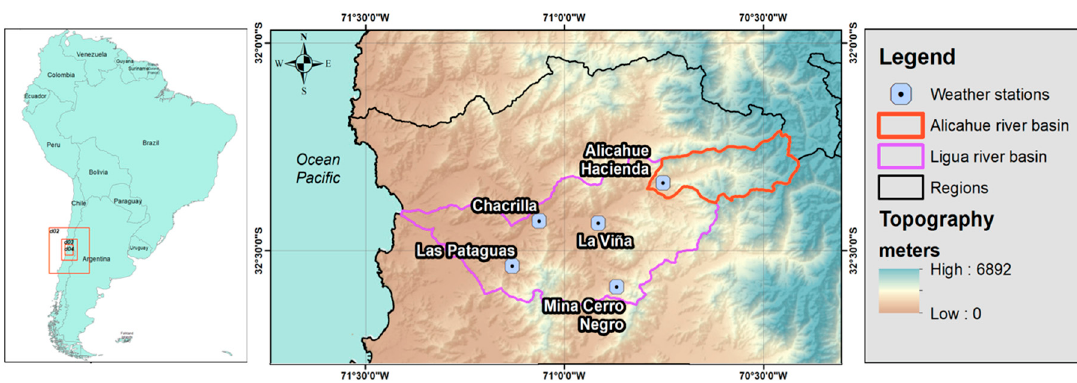
Figure 1. Area of study. Relative location in South America and Weather Research and Forecasting (WRF) domains (left), topography of the area of study indicating the limits of Alicahue and La Ligua River Basins (red and purple polygons, respectively) and the location of the weather stations (streamflow station co-located with Alicahue Hacienda weather station).